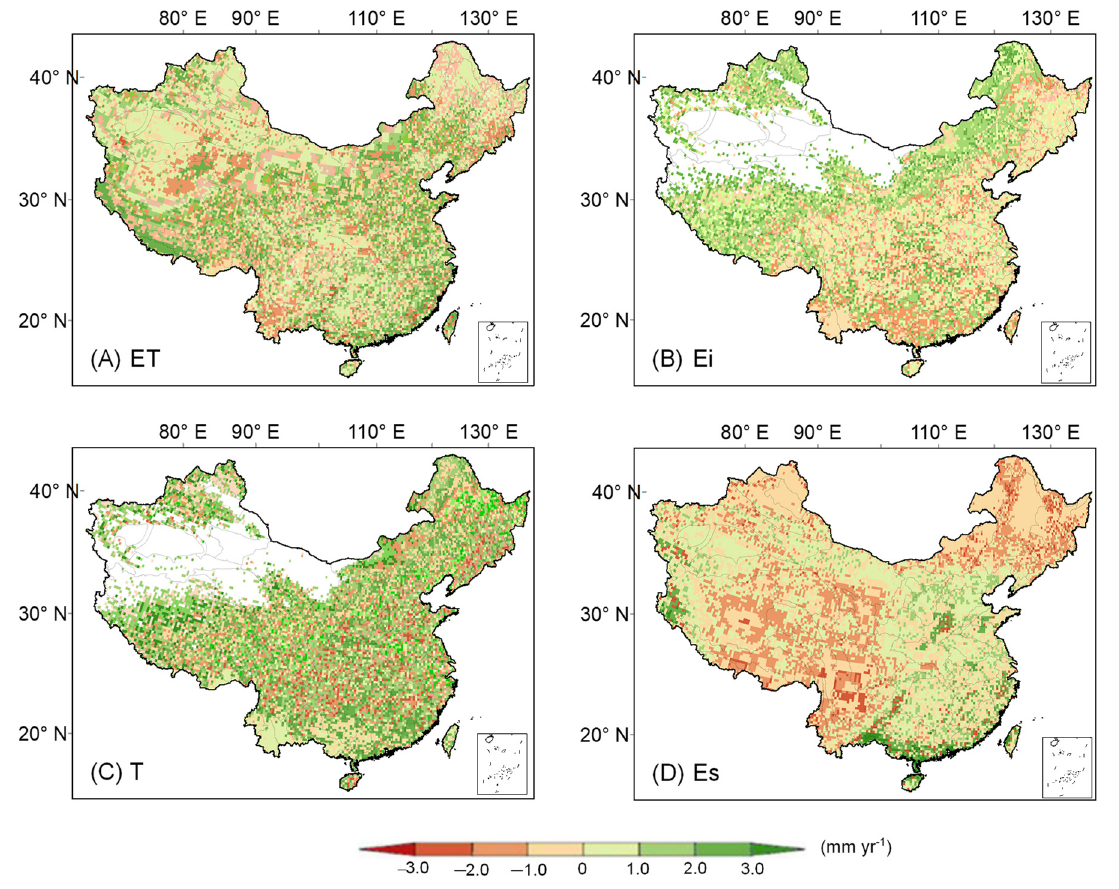
Figure 12. Annual trend slopes of ( A ) PT–SM evapotranspiration ( ET ); ( B ) canopy evaporation ( E i ); ( C ) vegetation transpiration ( T ); and ( D ) soil evaporation ( E s ) during 2003–2015.